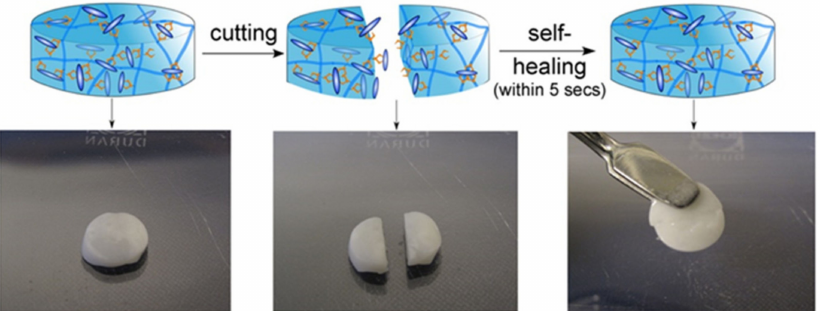
Figure 3. Self-healing behavior of non-covalently crosslinked HYH–CaP hybrid nanocomposites. Reproduced with permission [23]. Copyright Elsevier,